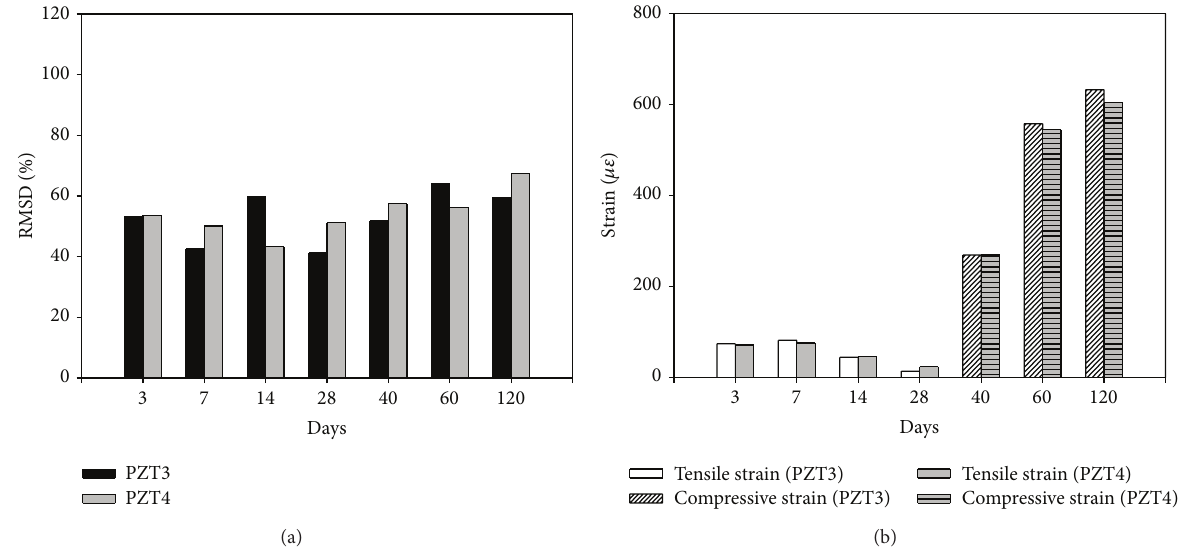
Figure 20: Comparison of PZT3 and PZT4: (a) RMSD value and (b) strain of concrete around EMI sensors.